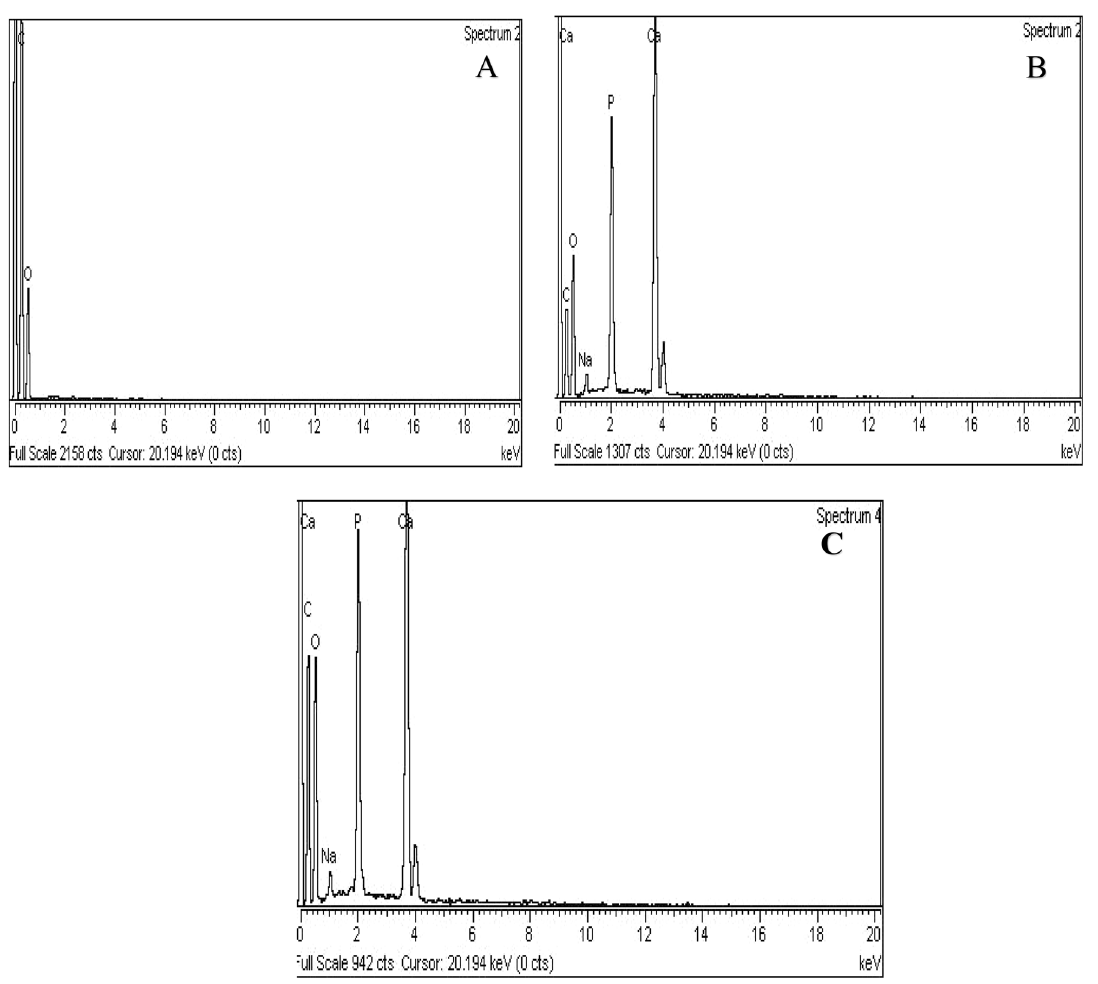
Fig. 4 EDX spectra of AR ( A ) and hybrid nanocomposites ( B ) WC and ( C ) CC